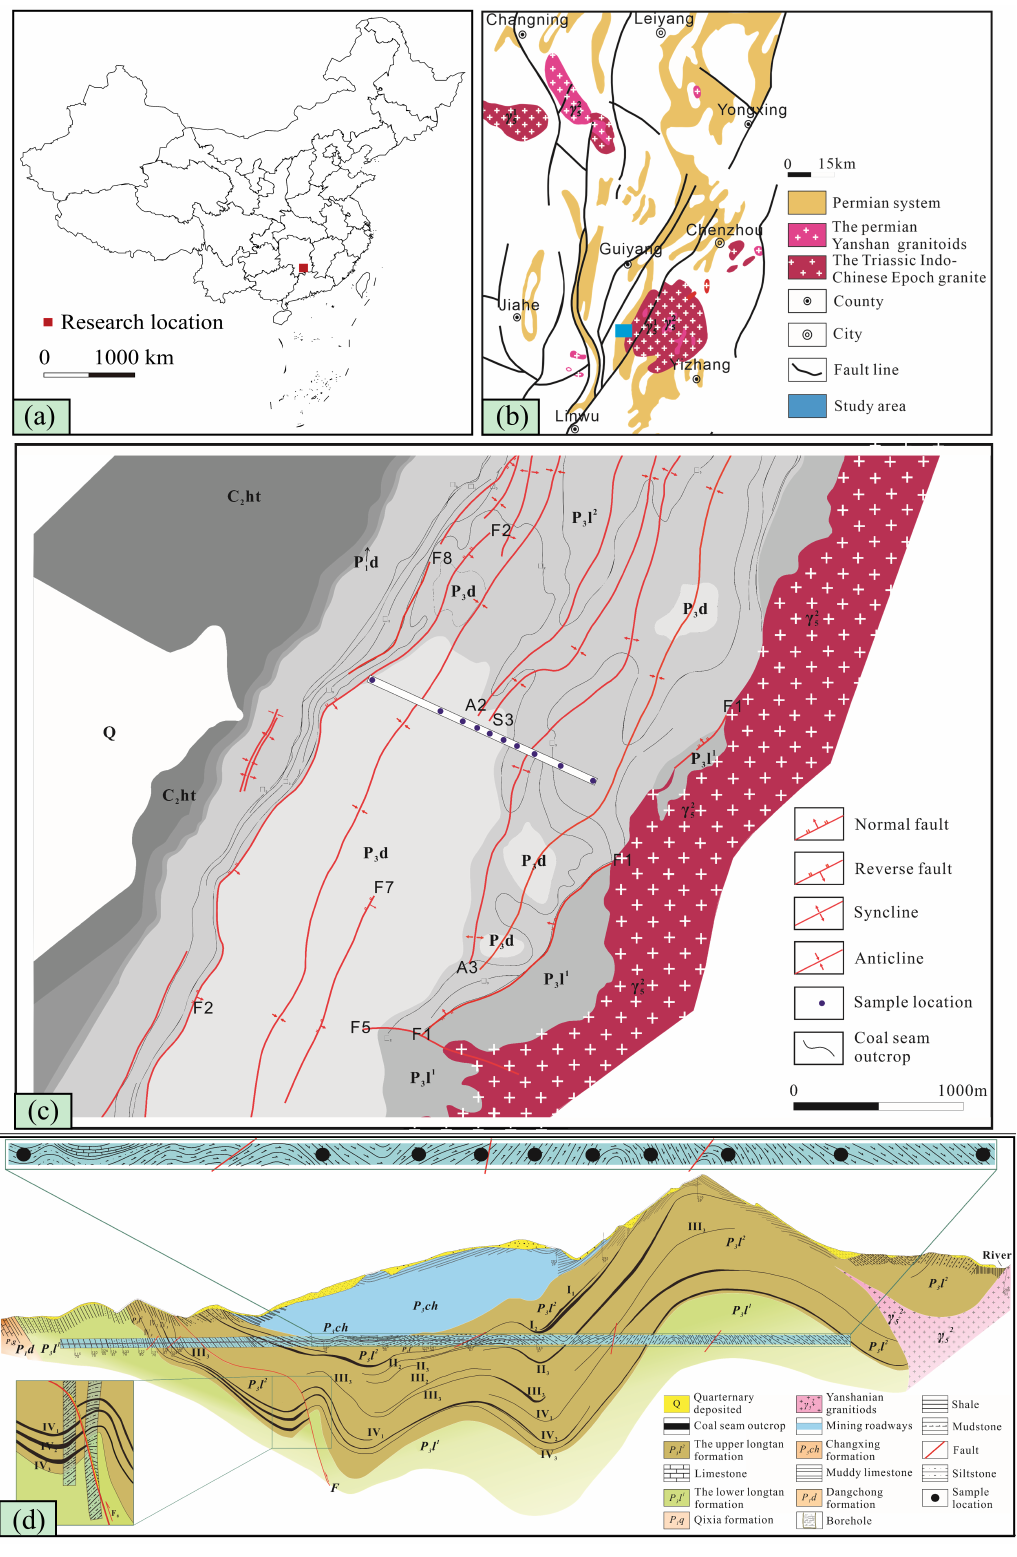
Figure 1. ( a ) Location of the research area; ( b ) geological sketch map of southern Hunan showing the general geological features of the study area (after Ma, 2002) [30]; ( c ) geological map of the study area with sampling positions; ( d ) schematic cross section through the mining area including the sampling positions. ( a , b ) have been redrawn and modified based on Zheng et al. (1986)